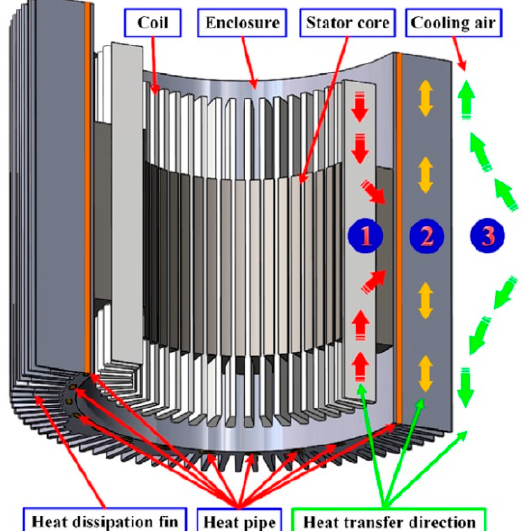
Figure 29. Heat pipe-based air-cooling with straight-embedded module (SEME) [62].